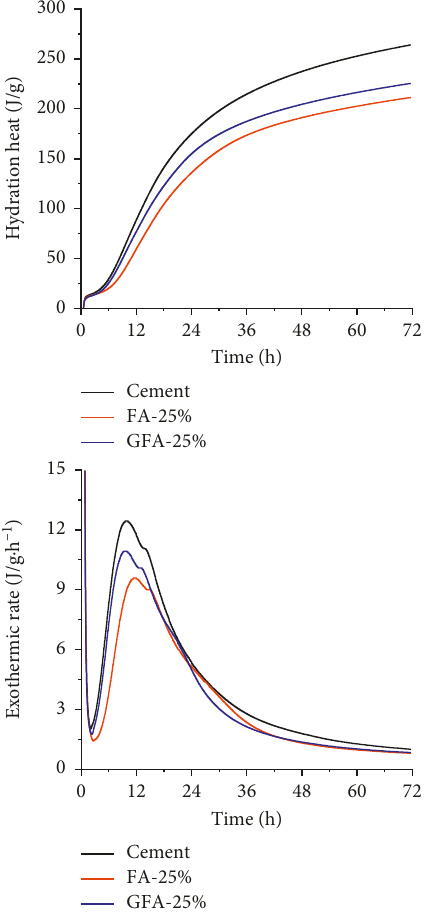
Figure 4: Hydration heat curves of composite cementitious